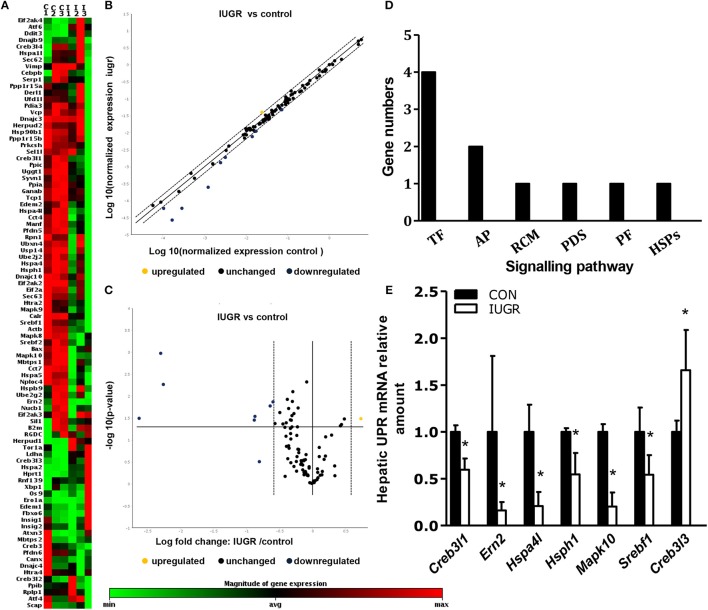
Determination of the expression of hepatic unfolded protein response (UPR)-related factors in IUGR foetuses by qPCR arrays. (A) K-means clustering representation of 84 mRNA profiles. The magnitude of the percentage is represented by a colour scale (top right) going from low (green) to high (red). (B,C) Scatter plot and volcano plot showing changes in mRNA expression between the two groups (n = 3). (D) Differentially expressed genes in six signalling pathways related to UPR in IUGR rats. RCM, regulation of cholesterol metabolism; ERAD, endoplasmic reticulum-associated degradation; TF, transcription factor; PF, protein folding; PDI, protein disulphide isomerization; HSP, heat-shock protein; Ap, apoptosis. (E) Differentially expressed genes between control and IUGR rats. The data are presented as the mean ±SEM. [n = 3 per group; *p < 0.05 vs. control (unpaired Student's t-test].